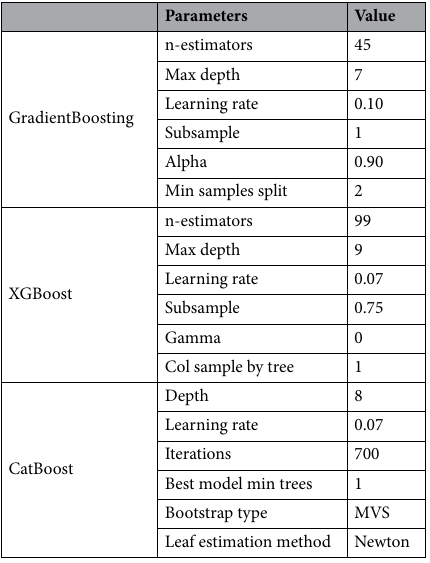
Table 2. Control parameters used for the development and application of soft computing